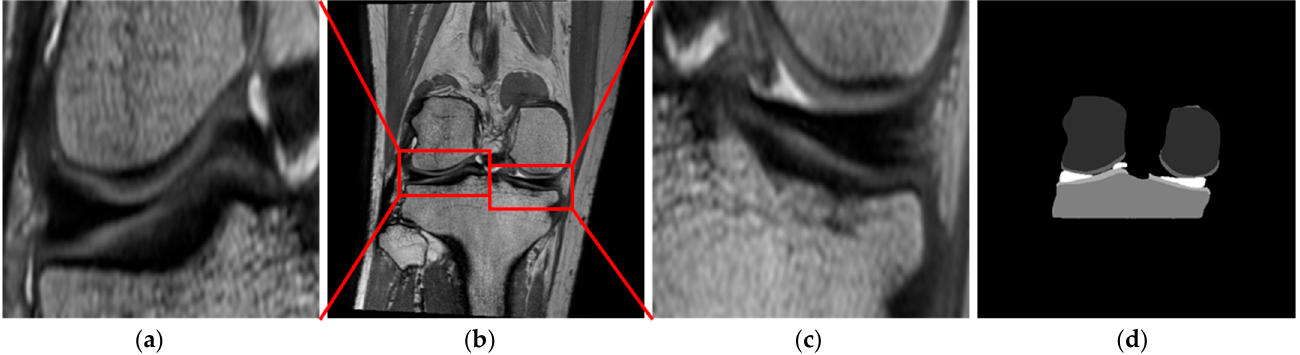
Figure 3. Automatic localization of the meniscus. ( a ) The medial meniscus localization. ( b ) Original image. ( c ) The lateral meniscus localization. ( d ) The 6 ‐ classes segmentation results (dark grey: femur, medium grey: femoral cartilage, grey: tibia, light grey: tibial cartilage, white: meniscus).